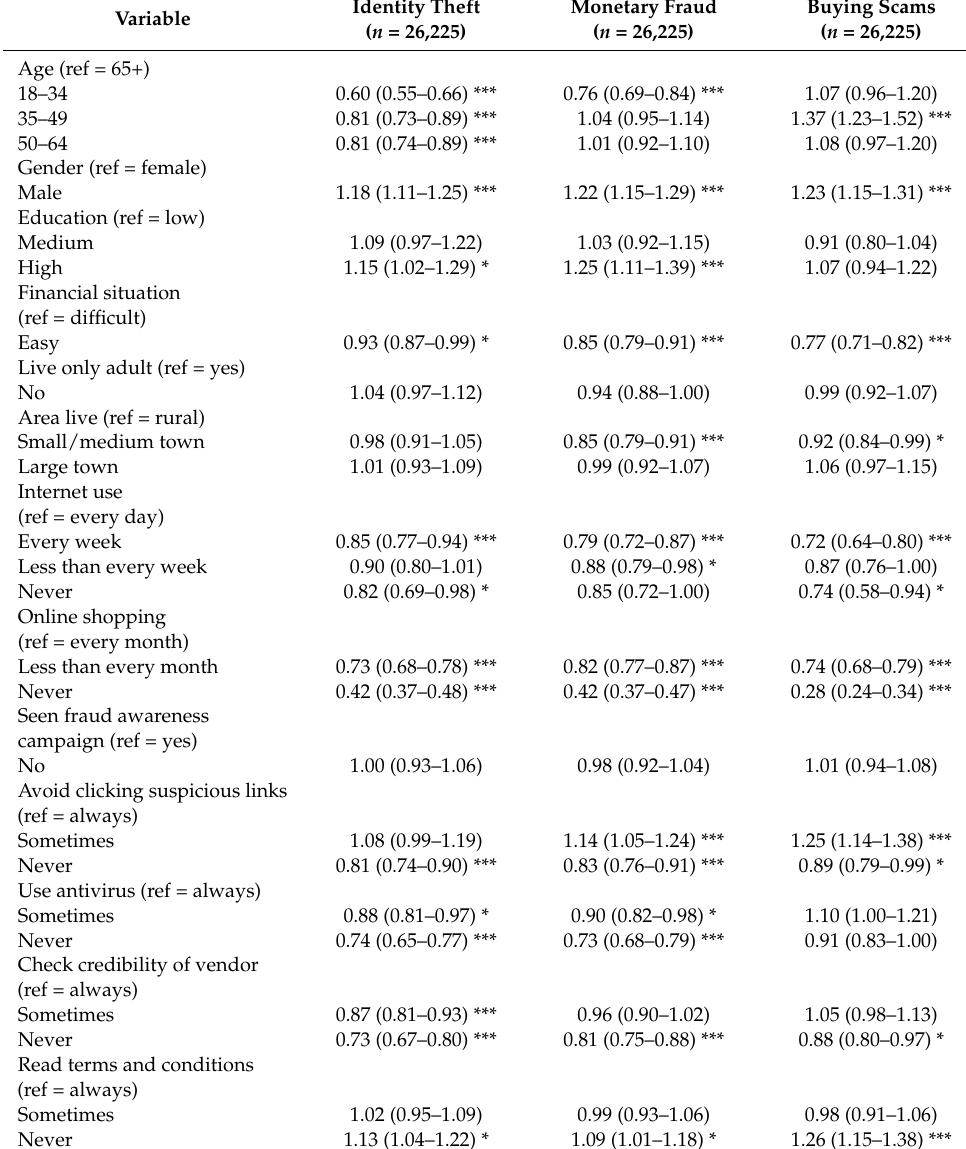
Table 9. Odds ratio and 95% CI for identity theft, monetary fraud, and buy